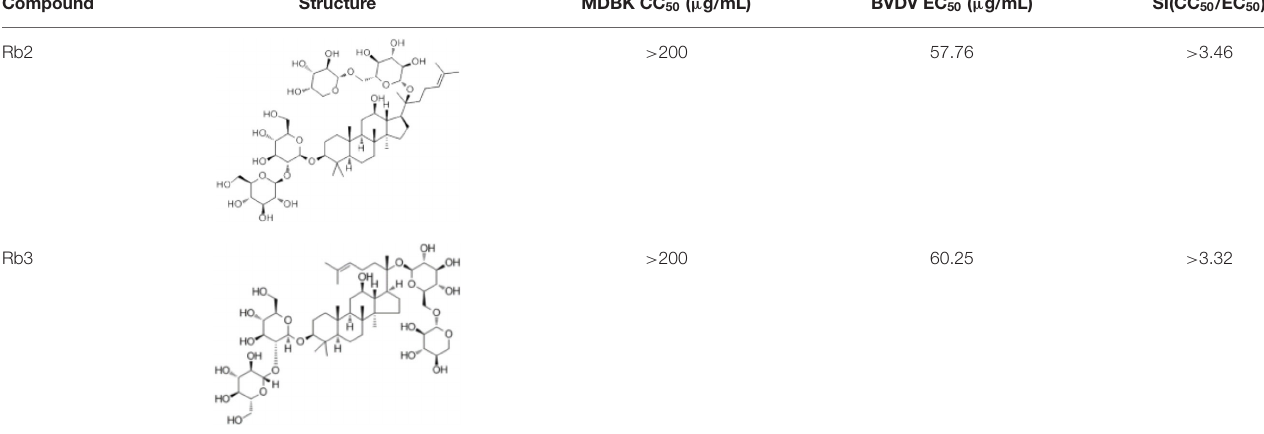
TABLE 1 | The structure and antiviral activity of Rb2 and Rb3. Compound